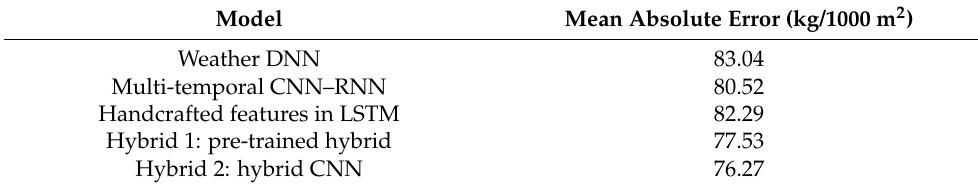
Table 5. Best mean absolute error achieved for each